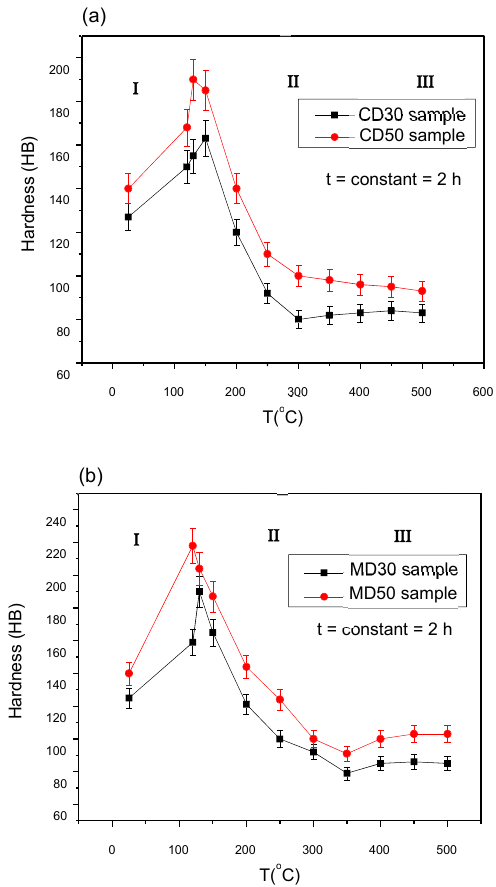
Figure 2. The effect of ageing temperature on the hardness of alloys in thermomechanical treatments with: ( a ) conventional dissolution, and ( b ) modified quenching.